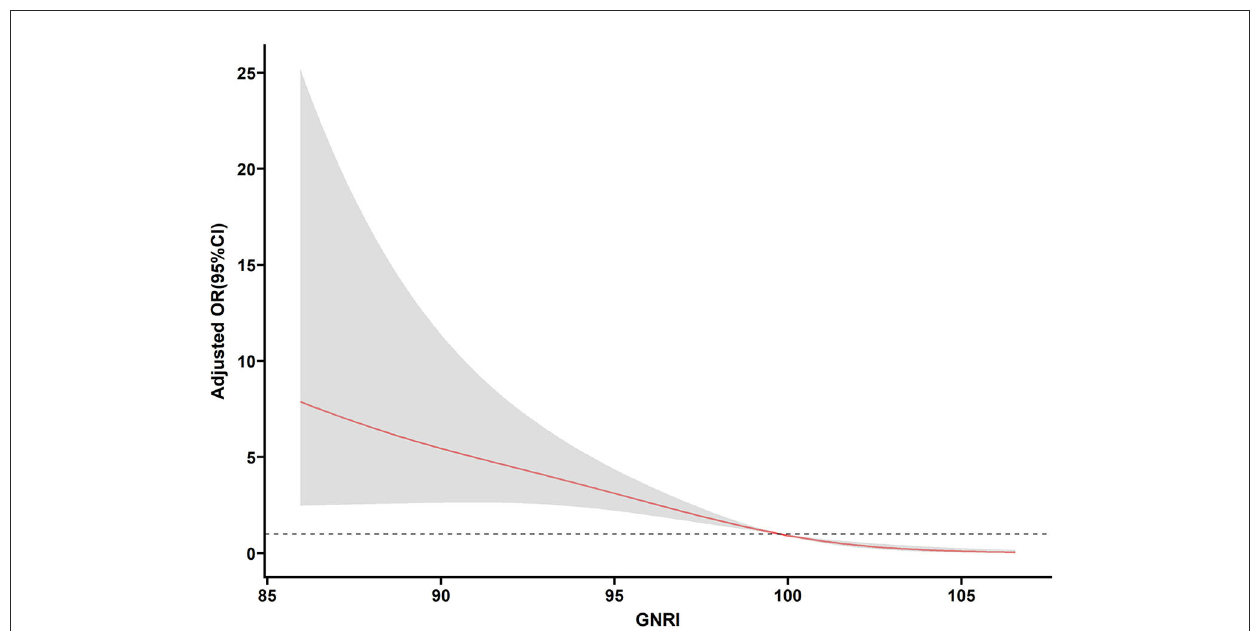
FIGURE4 Association of the GNRI and poor recovery in elderly mTBI patients. Odds ratios and 95% confidence intervals derived from restricted cubic spline regression ( p for non-linearity = 0.108), with three knots placed at the 5, 50, and 95th percentiles of the distribution of GNRI. Odds ratios were adjusted for the variables included in the fully adjusted model in Table